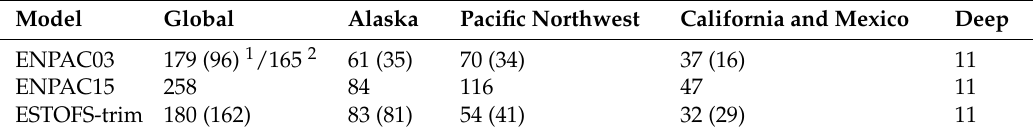
Table 5. Total number of validation stations available in each region for the most recent models in the ENPAC region.